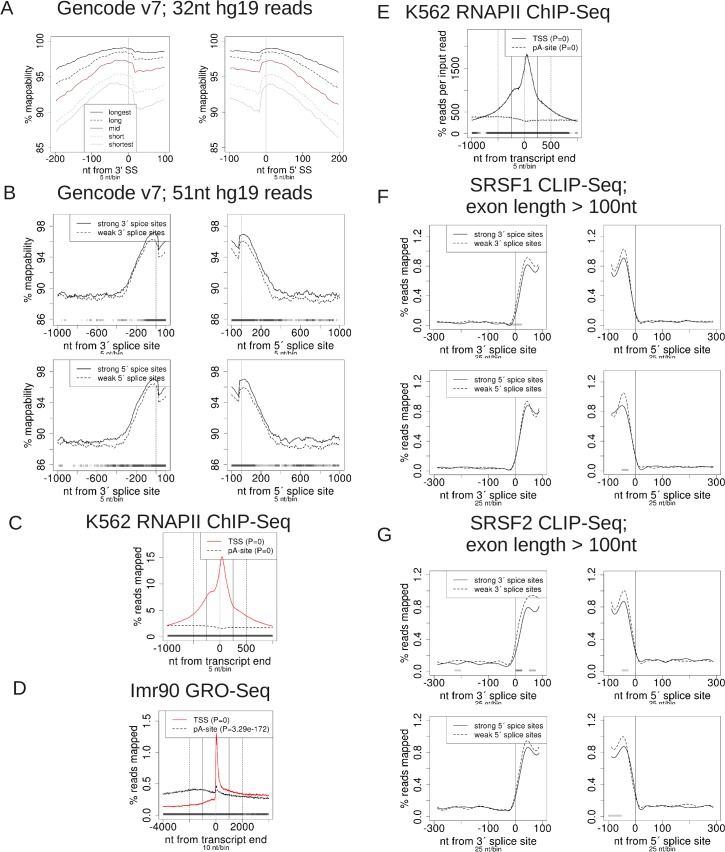
Validation Profiles.(A) Mappability according to transcript length. “Longest” gives the longest 20% of transcript lengths, “long” gives the 2nd longest 20% of transcript lengths, and so on. Each class has N = 11711 reference regions. (B) Mappability at the upper vs. lower quartile of splice site strengths, “strong” and “weak”, respectively. (C)-(E) Comparisons of regions surrounding transcription start sites (TSSs) and polyadenylation sites (pA-sites). The pA profiles have been inverted, such that for all these profiles, positive values on the x-axis indicate the distance into the transcript, whereas negative values indicate the distance outside of the transcript. (F)-(G) Mouse CLIP-Seq profiles at strong vs. weak exons. Test vs. control P-values/bin are as shown in Fig 1B, with the lightest shade of grey corresponding to P-value < 0.01.